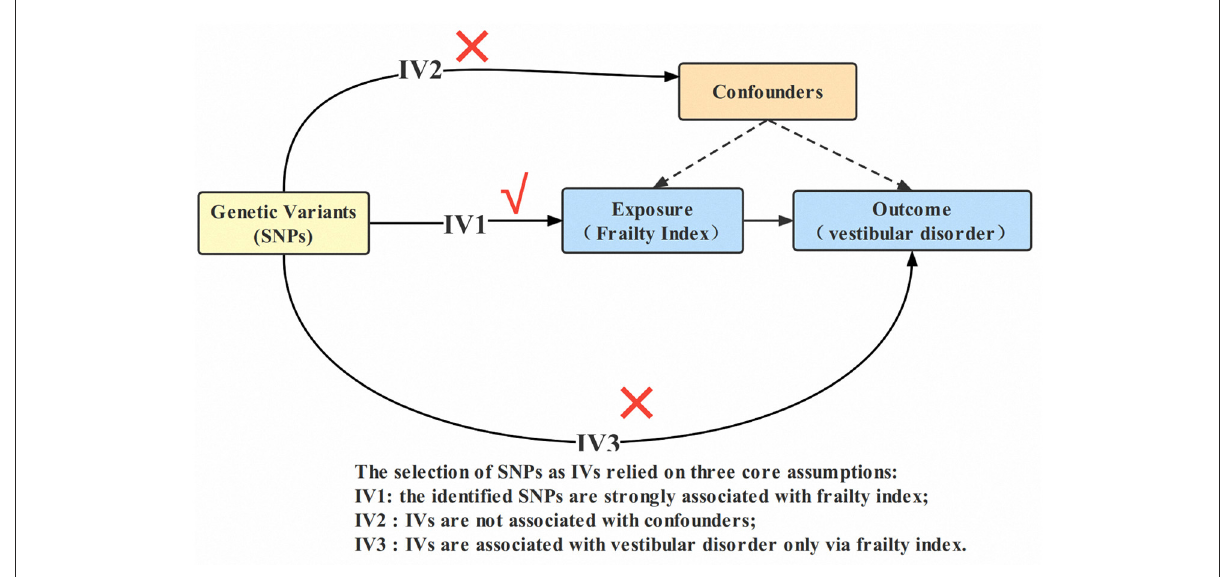
FIGURE1 Design of the two-sample Mendelian randomization study. IVs, instrumental variables; SNP, single nucleotide